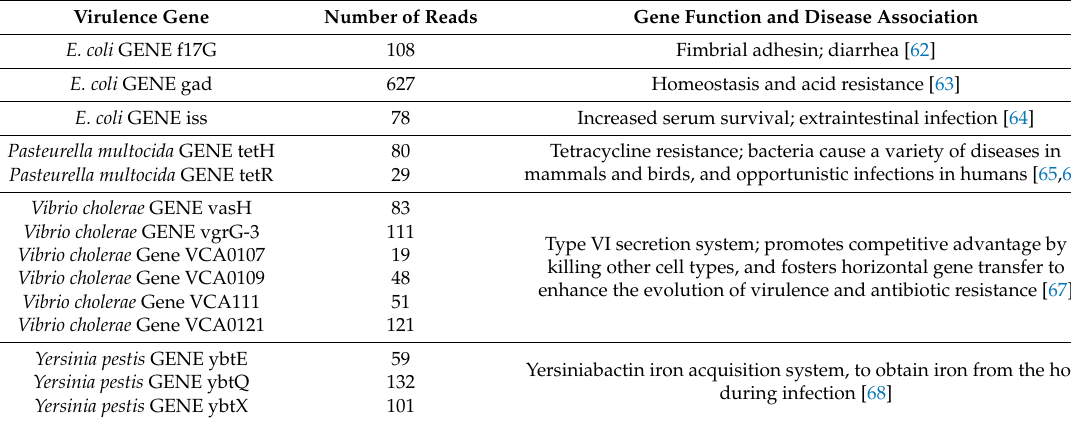
Table 7. Virulence genes identified by analysis of the metagenome derived from DNA prepared after selective growth on m-ColiBlue24